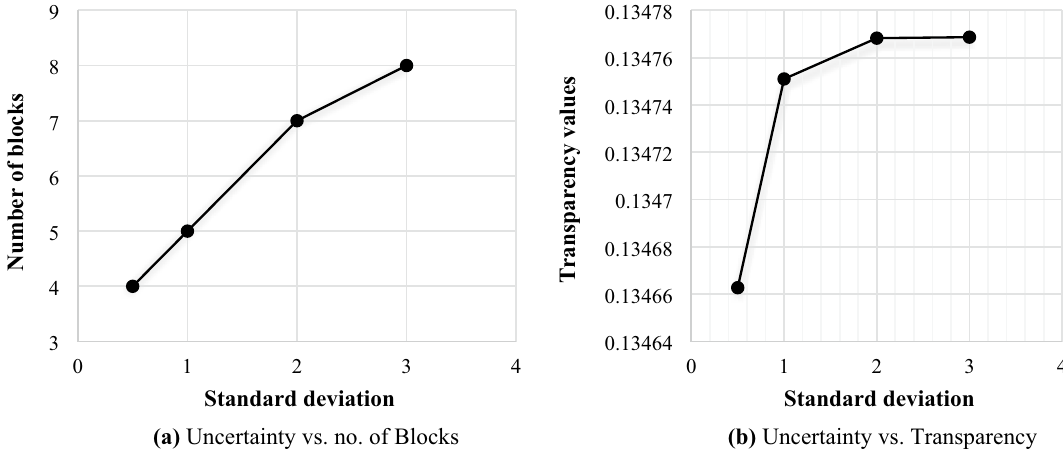
Figure 3. Relationship between uncertainty and blockchain technology.